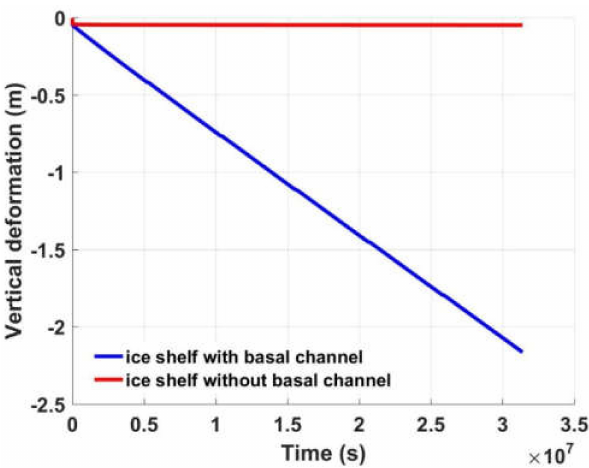
Figure 4. The annual vertical displacement at the geometric center of the ice shelf surface. (The location is indicated by the black arrow in Figure